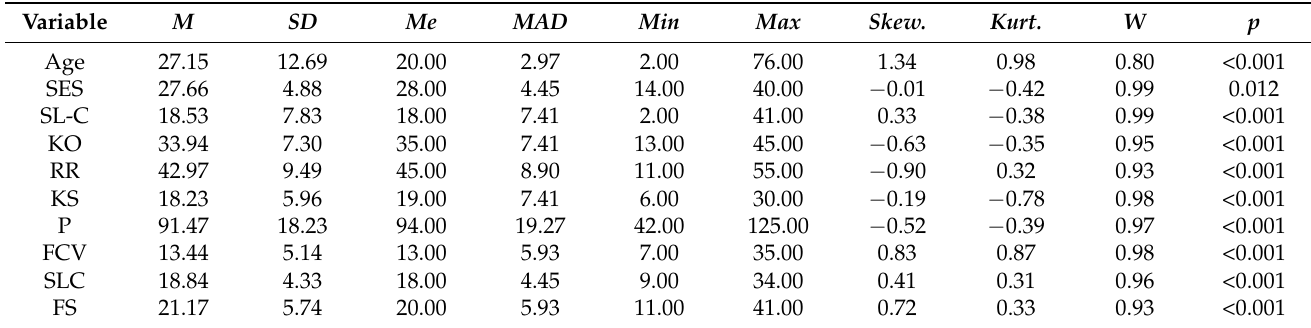
Table 2. Descriptive statistics and normality tests for all scales and